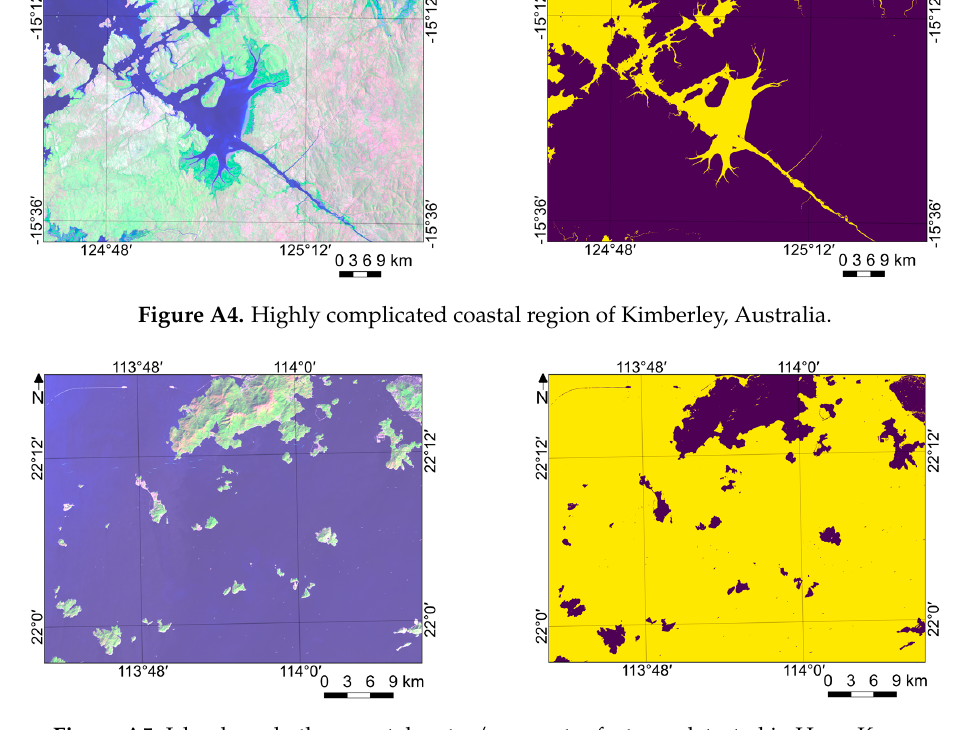
Figure B5. Islands and other coastal water/non-water features detected in Hong Kong. Figure B6 and Figure B7 show the temporal changes of water/non-water region in Machagora Dam, Madhya Pradesh region.